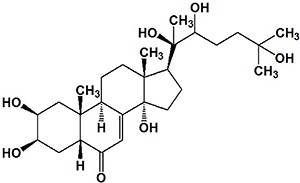
Representation of 20-hydroxyecdysone molecular structure (C27H44O7). PubChem CID: 5459840.